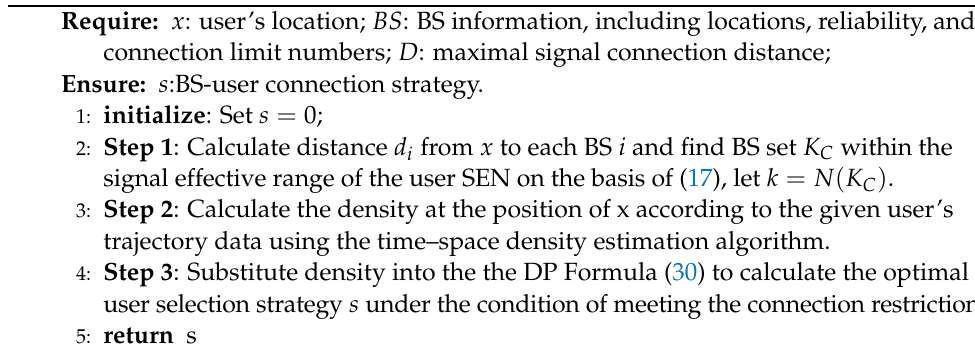
Algorithm 3: Wireless BS selection-strategy optimization based on trajectory